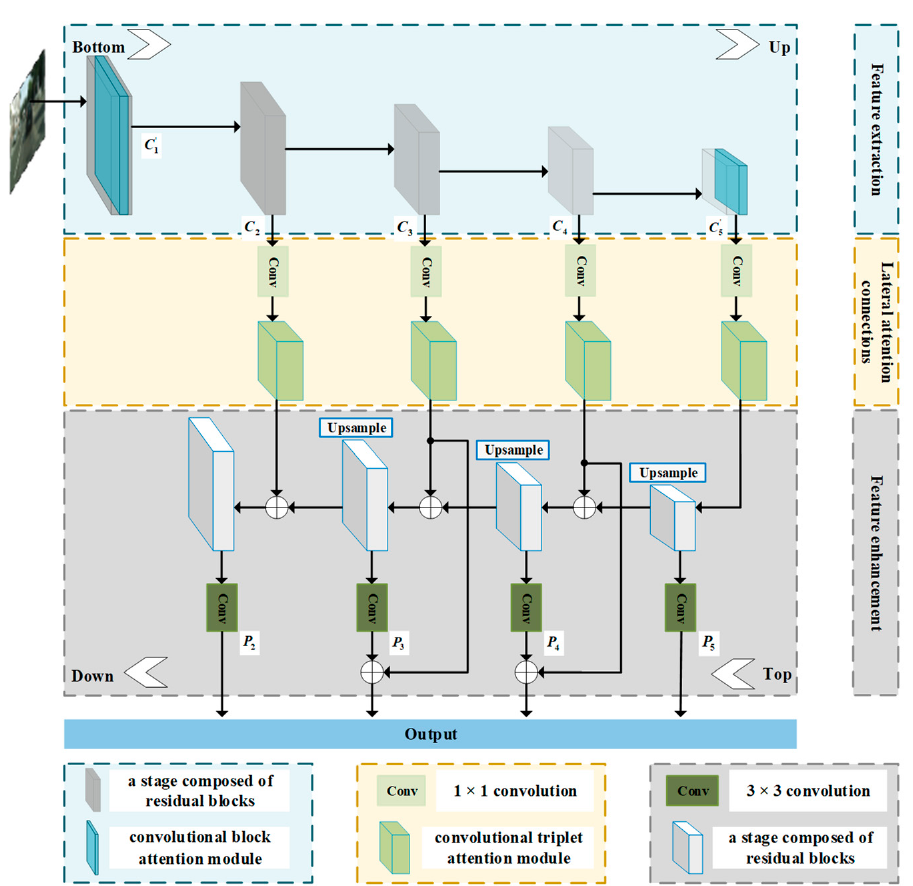
Figure 1. The architecture of the attention-based feature pyramid module (AFPM).